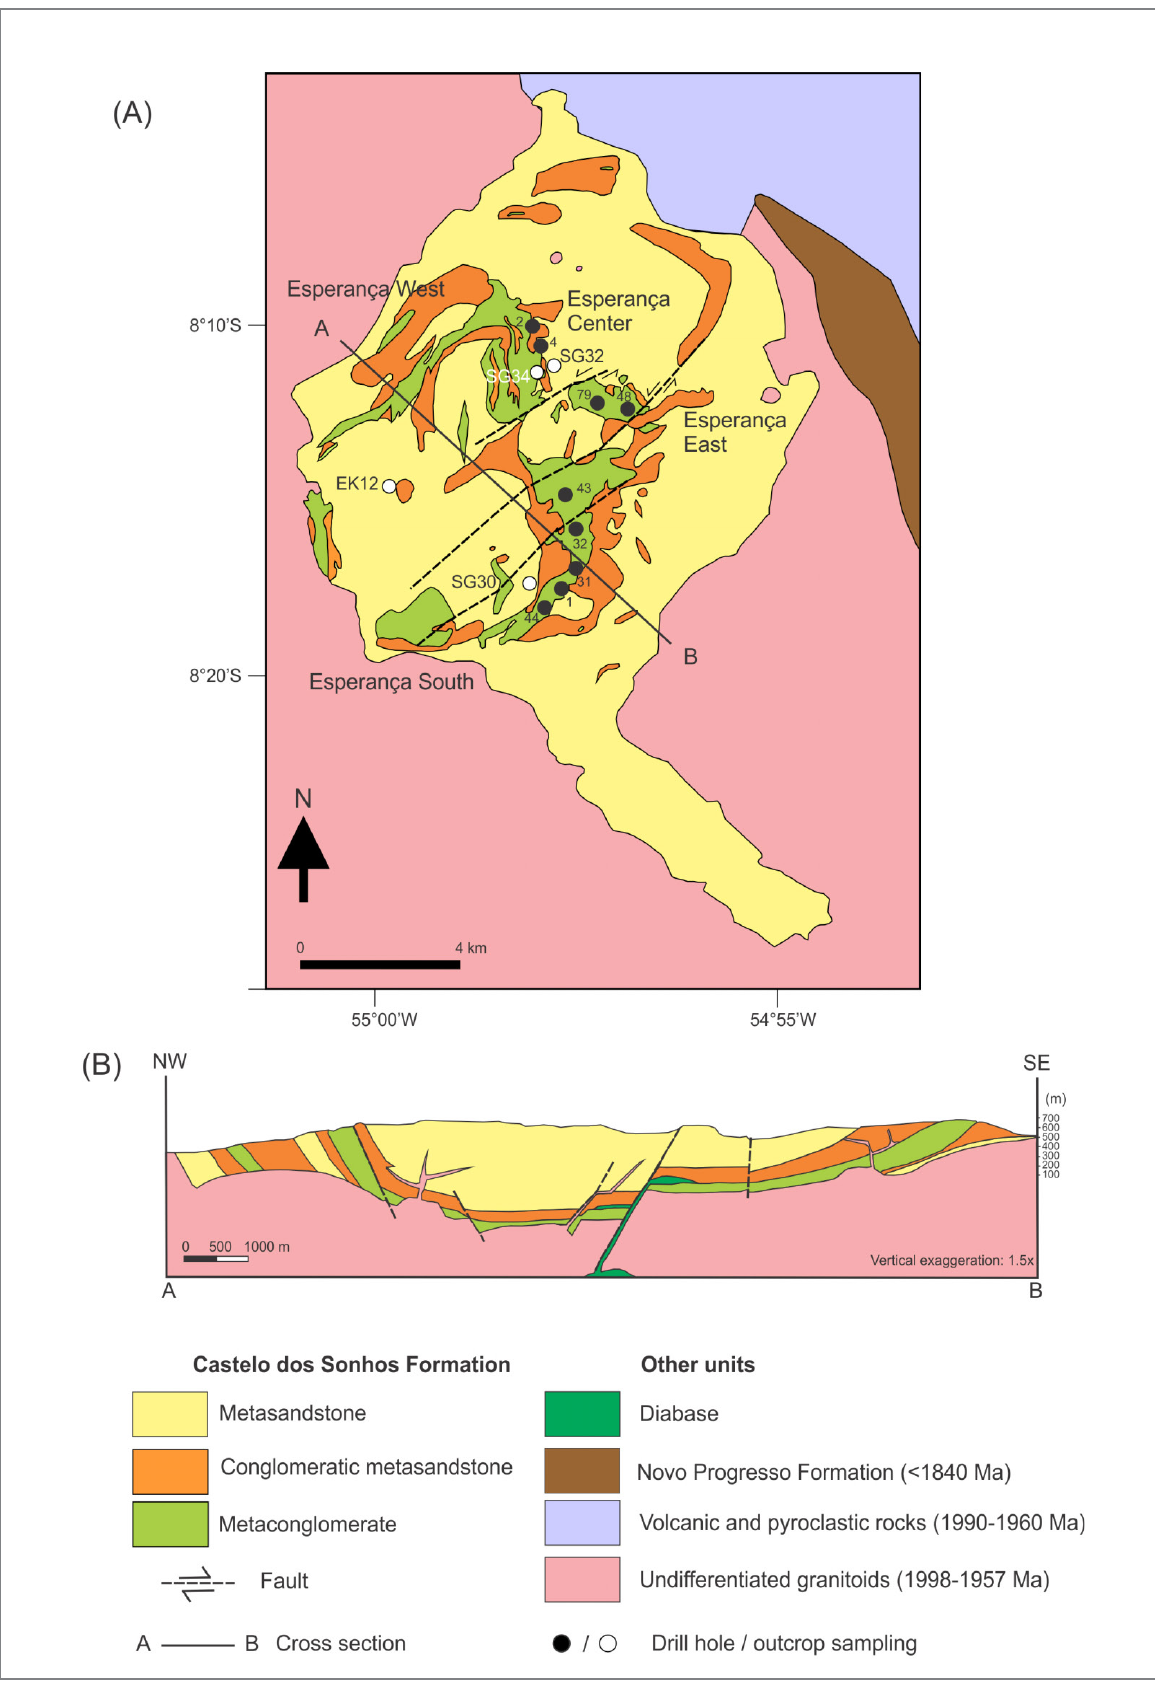
Figure 3 - (A) Geological map of the Castelo dos Sonhos Formation (modified from Mello 2014) and the surrounding area (adapted from Guimarães et al. 2015), with location of the mineralized targets (Tristar Gold 2018) and of the drill holes and outcrops sampled for this study (see also Appendix A for coordinates of the samples). (B) NW–SE cross